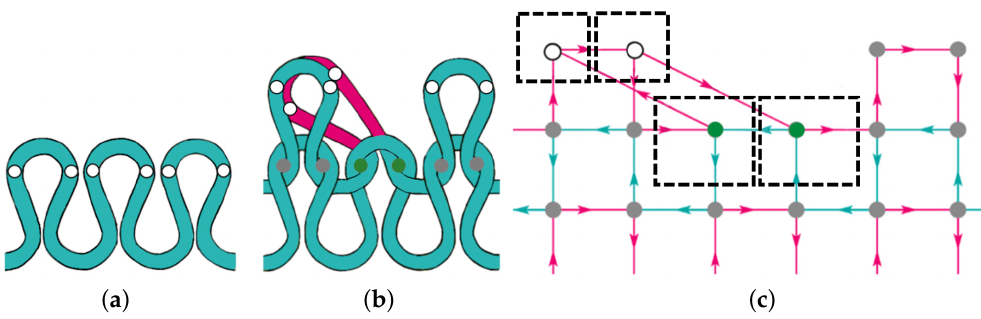
Figure 5. A Back Transfer stitch is created when the loop of a Purl stitch is transferred up to three needle positions away to the left or right. ( a ) Row of loops. ( b ) Two Knit stitches and a Back Transfer stitch produced from another row of stitches. ( c ) Topological representation.